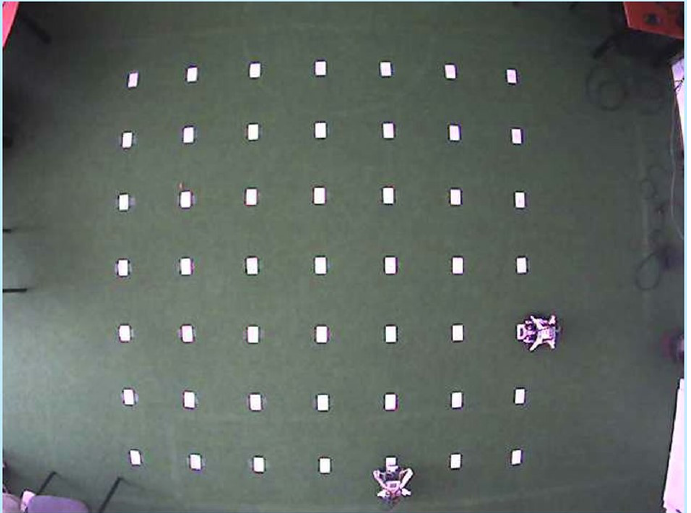
Figure 4. Use of a sparse RFID network with tags on the floor in combination with the sonar object detection. In this case the obstacle is another